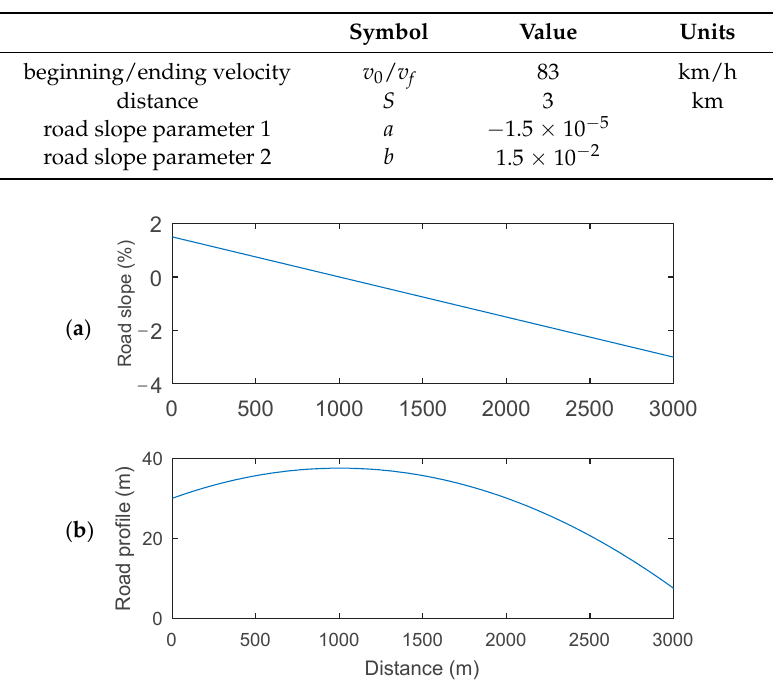
Figure 4. Convex road profile and its road slope. ( a ) Road slope profile; ( b ) road profile.